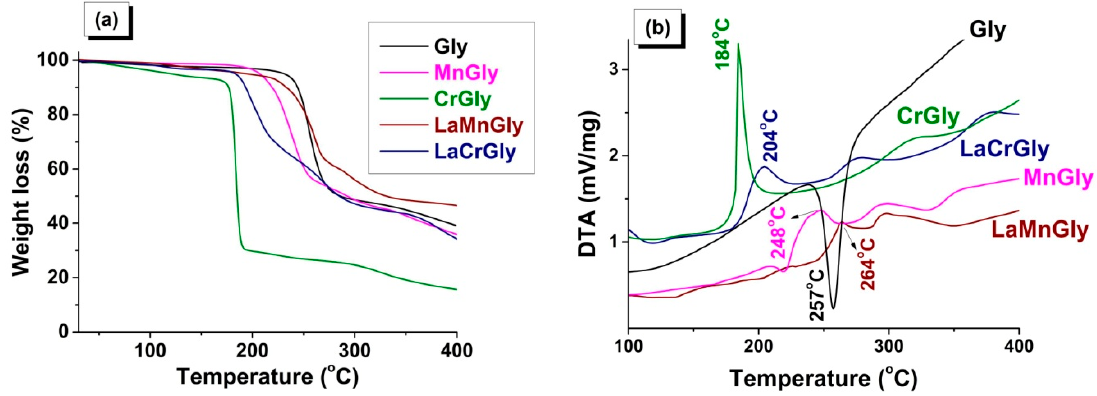
Figure 3. Thermal analysis of Gly, MnGly, CrGly, LaMnGly, and LaCrGly: ( a ) TG curves; ( b ) DTA curves (He, 20 mg, 10 °C/min).